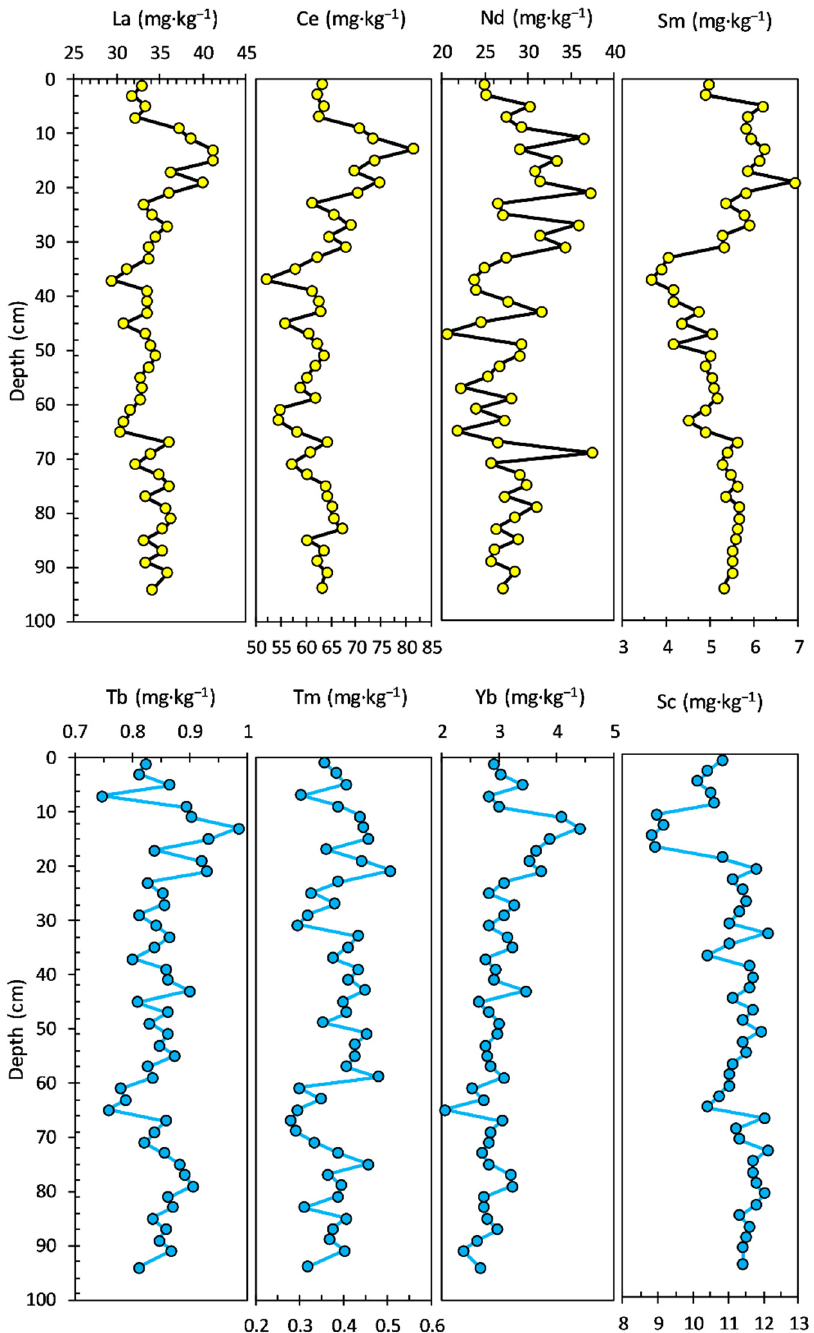
Figure 4. Vertical distribution of geochemical light rare earth elements—LREE (La, Ce, Nd, Sm) and heavy rare earth elements—HREE (Tb, Tm, Yb, Sc) in the Amara Lake sediment core (94 cm